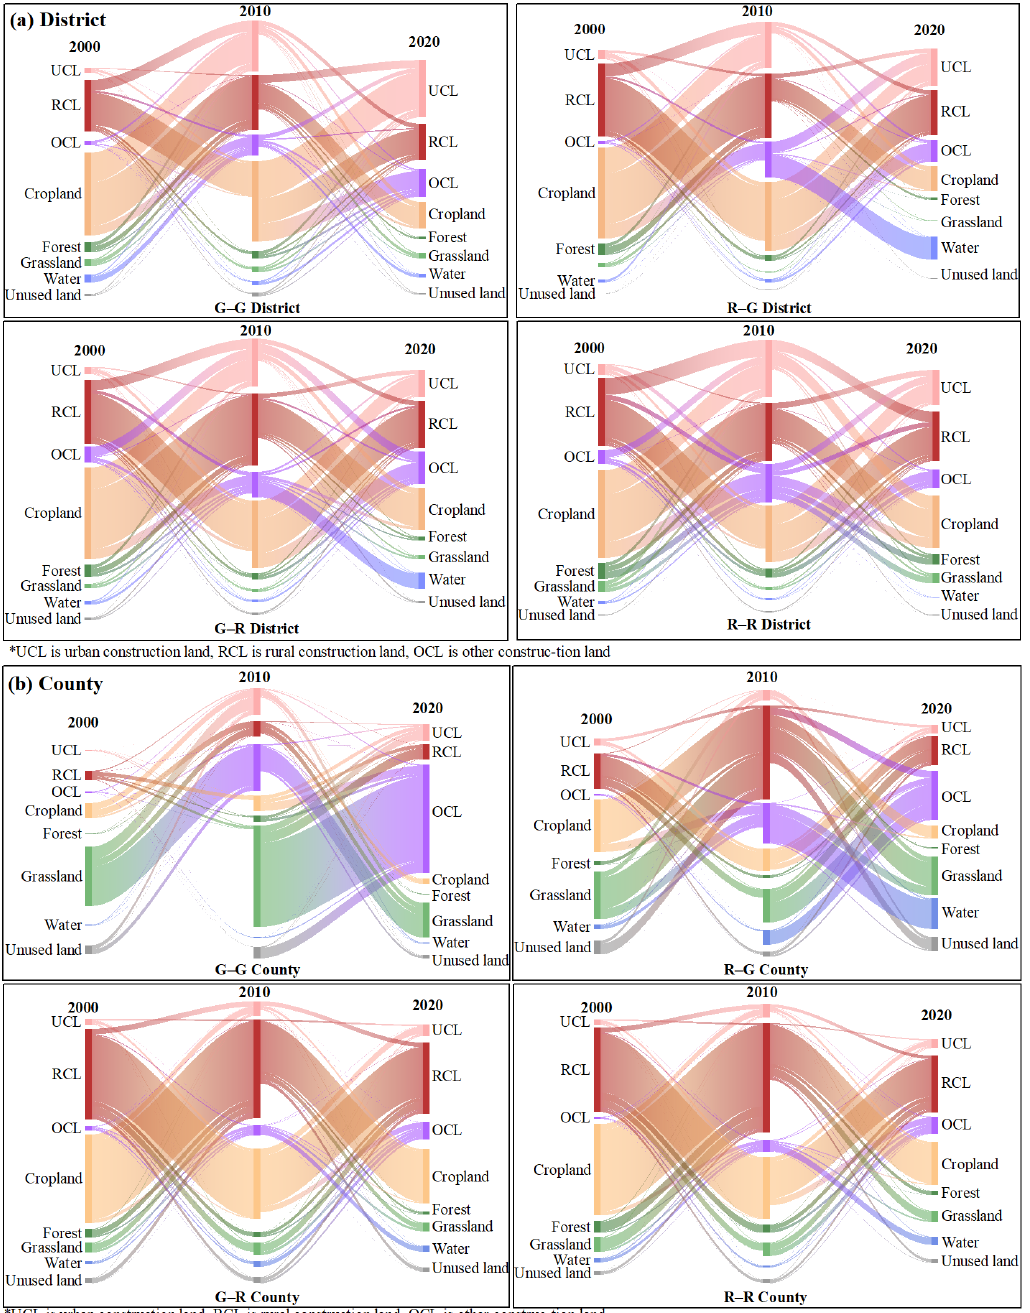
Figure 7. ( a ) Transfer of land use in different district types. ( b ) Transfer of land use in different county types.